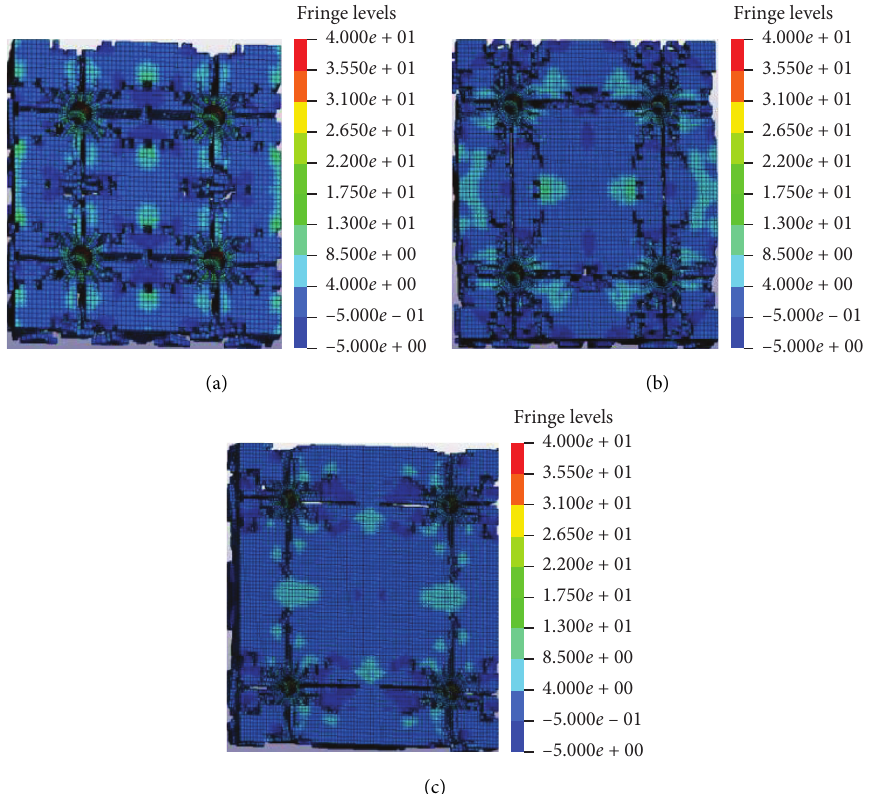
Figure 13: Simulation results of concrete slabs with different hole spacing. (a) S � 200mm. (b) S � 300mm. (c) S �